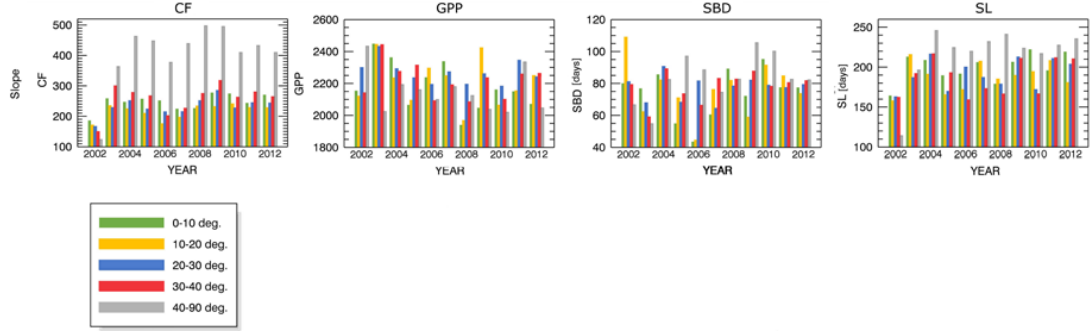
Figure A3. Marginal means plots of repeated measures ANOVA showing CF, GPP, SBD and SL variability in relation to slope. Analyses performed for the 3nNDVI drought impact class 3 spatial footprint. Abbreviations are explained in Table A1.